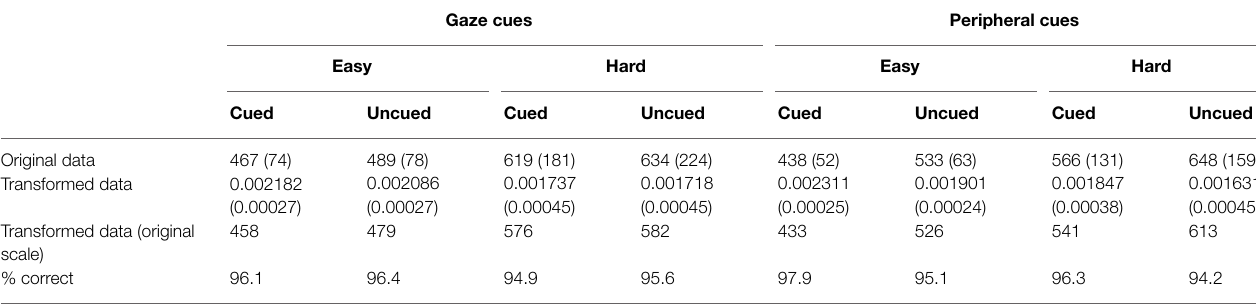
TABLE 2 | Means and standard deviations (in parentheses) of responses in each condition of Experiment